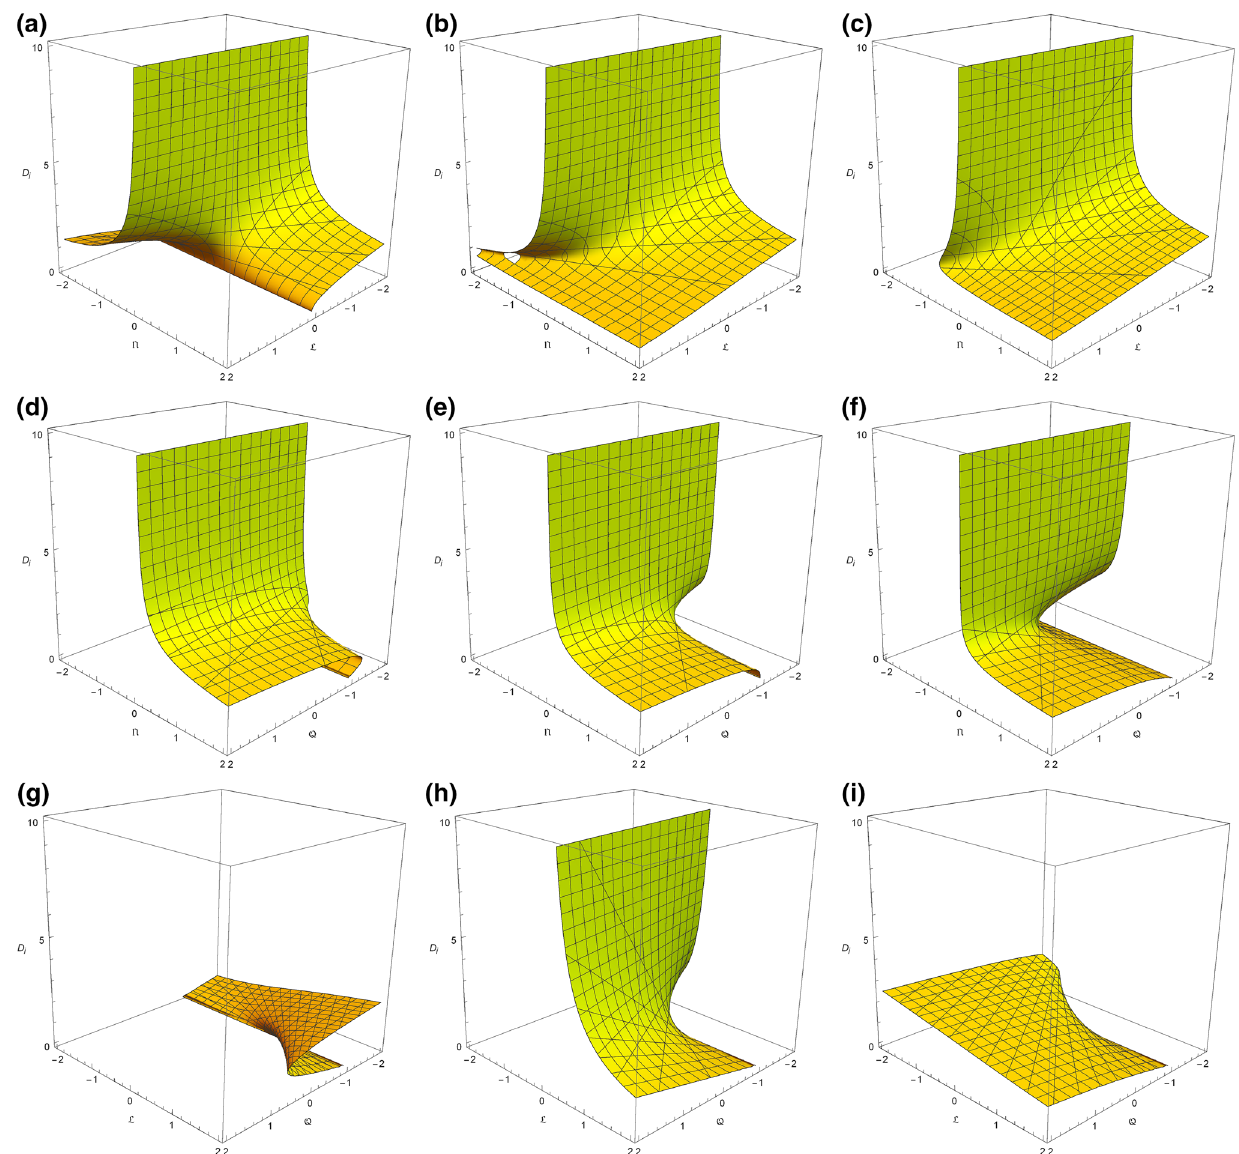
Fig. 13 The variation of D i versus typical values of the L , Q and N parametersin(48)forthequintessencebackground.Wehaveset M = 1 without loss of generality in all the plots. The plots a – c represent the